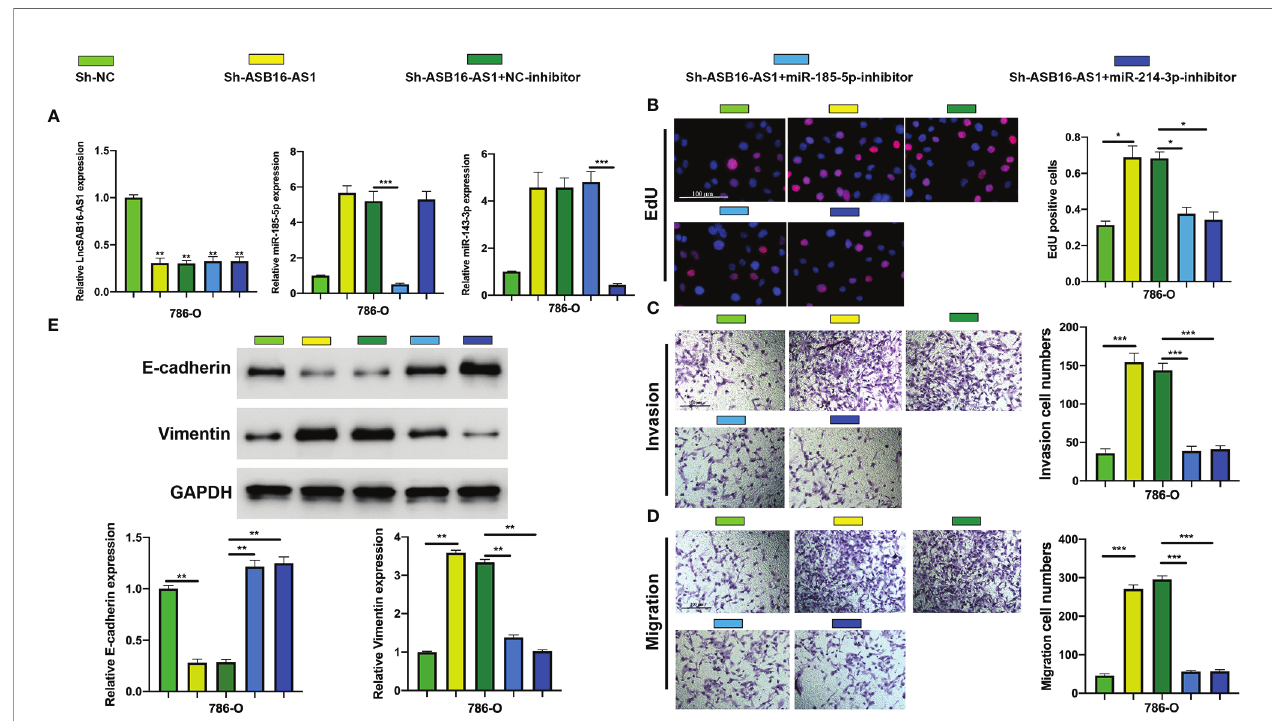
FIGURE 5 | MiR-185-5p and miR-214-3p inhibition rescues the promotive effects of downregulated ASB16-AS1 on HCC progression. (A) Cell models were generated by transfecting Sh-NC, Sh-ASB16-AS1, Sh-ASB16-AS1+NC-inhibitor, Sh-ASB16-AS1+miR-185-5p-inhibitor, and Sh-ASB16-AS1+miR-214-3p-inhibitor in 786-O cells, respectively. The expression of ASB16-AS1, miR-185-5p, and miR-214-3p in shRNAs and inhibitor conditions were measured by qRT-PCR. (B) Determination of cell proliferation ability by performing EdU assays. (C) Determination of cell invasion ability by using Transwell invasion assays. (D) Determination of cell migration ability by using Transwell migration assays. (E) Expression of the epithelial-mesenchymal-transition associated proteins E-cadherin and Vimentin were detected by western blot assays, which are quanti fi ed in the bottom left graphs. All experiments were repeated at least three times. Scale bars -100 m m, *P < 0.05, **P < 0.01, ***P <